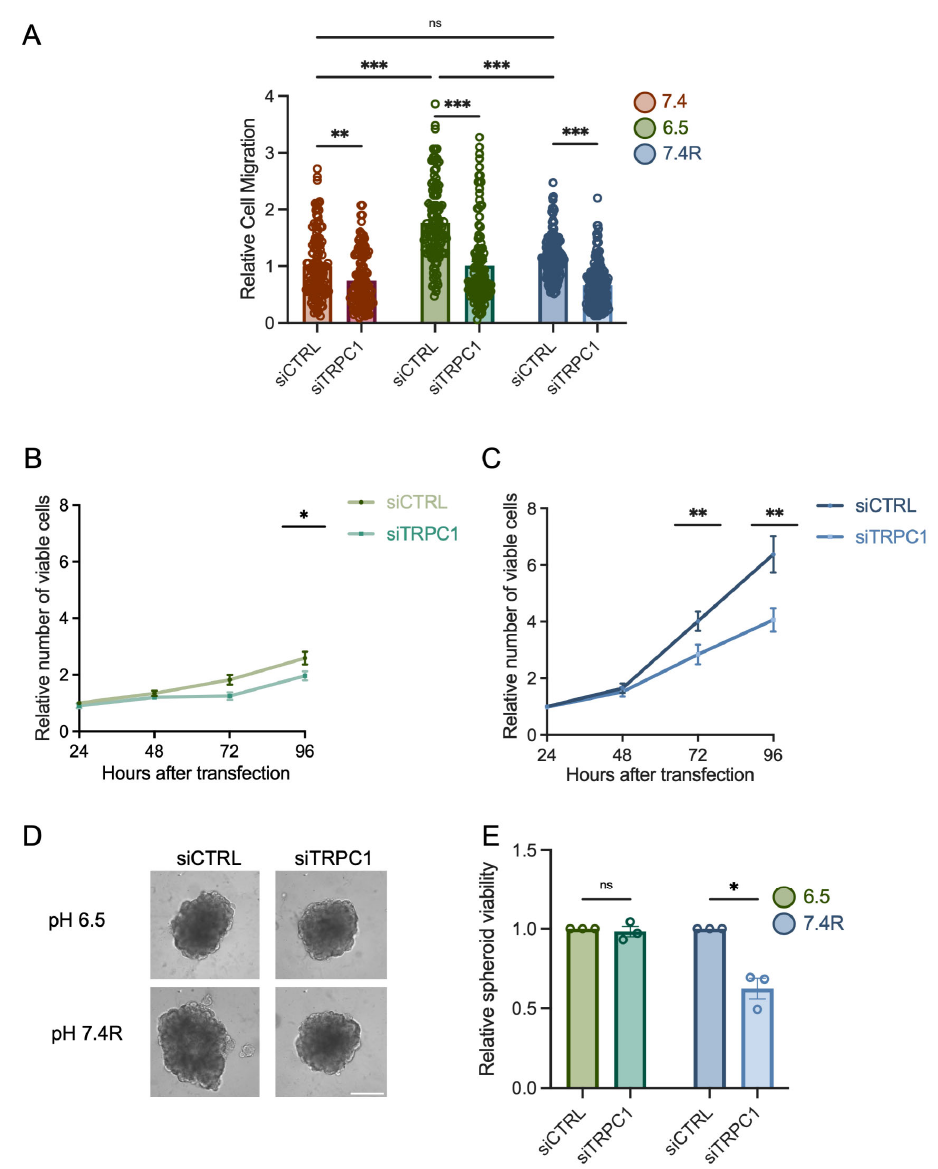
Figure 3. TRPC1 silencing inhibits cell migration, proliferation, and the growth of PANC-1 spheroids under acid recovery conditions. ( A ) Cell migration of siTRPC1 cells grown under normal pH (7.4), acid adaptation (6.5), or acid recovery conditions (7.4R) analyzed by Boyden chamber assay ( n = 3–4). Tukey’s multiple comparison test was used to determine significant differences between conditions. ( B ) Trypan blue analysis of siTRPC1 PANC-1 cells grown under acid adaptation (6.5), or ( C ) acid recovery conditions (7.4R), showing the relative number of viable cells 24, 48, 72, and 96 h post- transfection ( n = 3–5). ( D ) Representative images of siTRPC1 transfected PANC-1 spheroids grown for 9 days, and ( E ) viability quantification performed with CellTiter-Glo ® assay of siTRPC1 transfected spheroids grown under acid adaptation (6.5) or acid recovery (7.4R) ( n = 3), scale bar = 400 µ m. Welch’s correction t ‐ test was used to determine the significant difference between siCTRL and siTRPC1 conditions. ns indicates non ‐ significance. *, **, and *** indicate p < 0.05, 0.01, and 0.001, respectively.